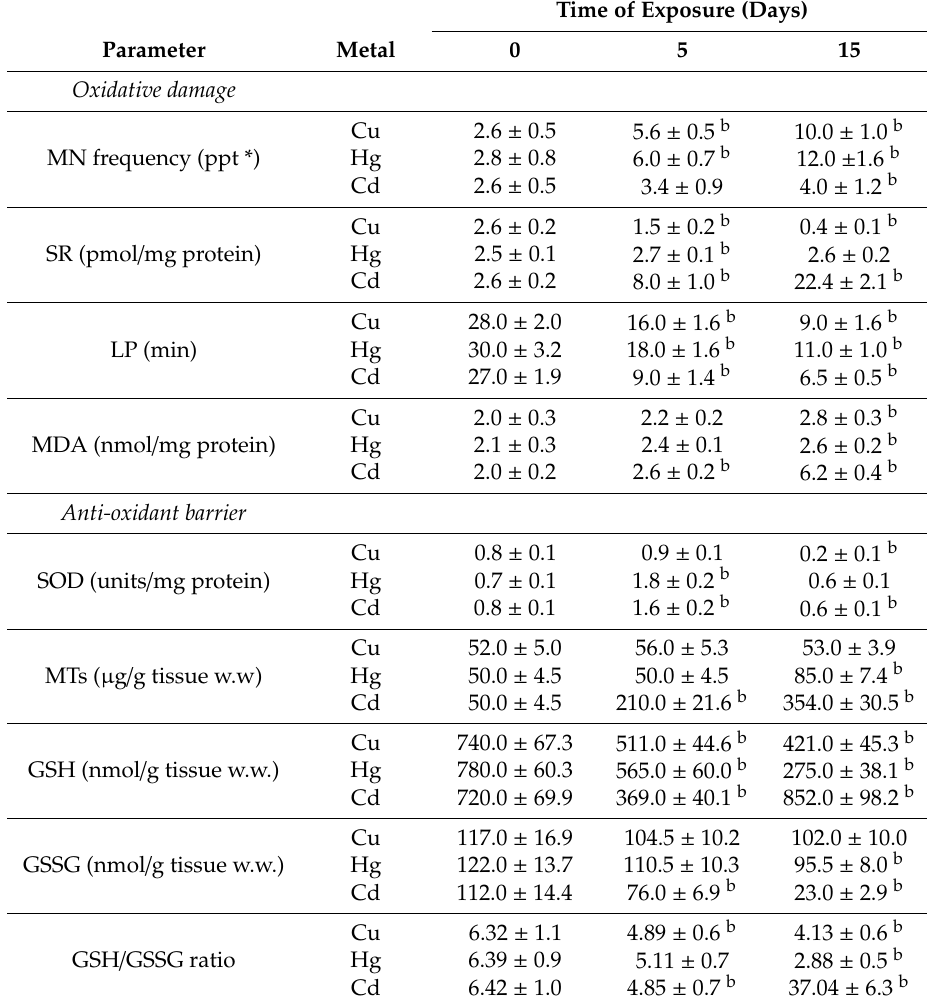
Table 1. Biomarker measurements in digestive gland of mussels non-exposed or exposed to 40 µ g / L Cu, 30 µ g / L Hg, or 100 µ g / L Cd for 5 or 15 days a